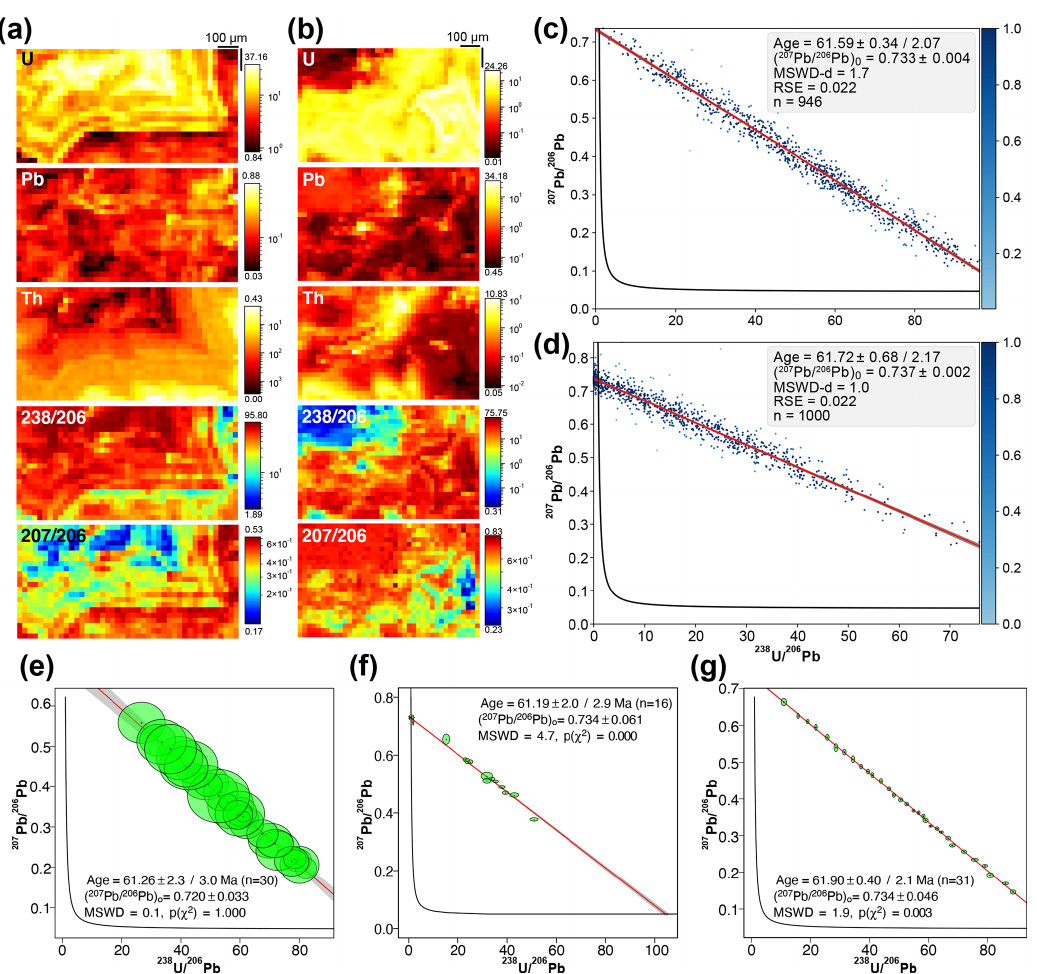
Figure 3. Results obtained for two isotopic maps of sample BH14: (a, c, e, g) first map; (b, d) second map. (a, b) Semi-quantitative element concentrations in parts per million (U, Pb and Th) and 238 U / 206 Pb– 207 Pb / 206 Pb isotopic maps. (c, d) TW concordia plots with ages and their uncertainty calculated by robust regression. (e) TW concordia plot with age and its uncertainty calculated from discretisation of the isotopic map (pseudo-spots). (f) TW concordia plot obtained from LA-ICP-MS spot analyses. (g) TW concordia plot obtained with the approach of Drost et al. (2018). For panels (e) , (f) , (g) and similar plots in the next figures, the ages and associated uncertainties were obtained from York-type regression using IsoplotR; age uncertainties (1.96 σ level) are without (left) and with (right) systematic